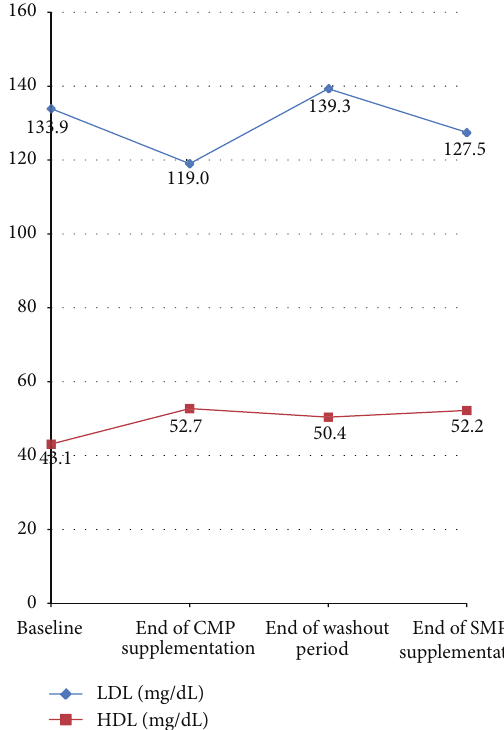
Figure 2: Graphic representation of LDL and HDL changes follow- ing supplementation with Coconut milk and Soya milk